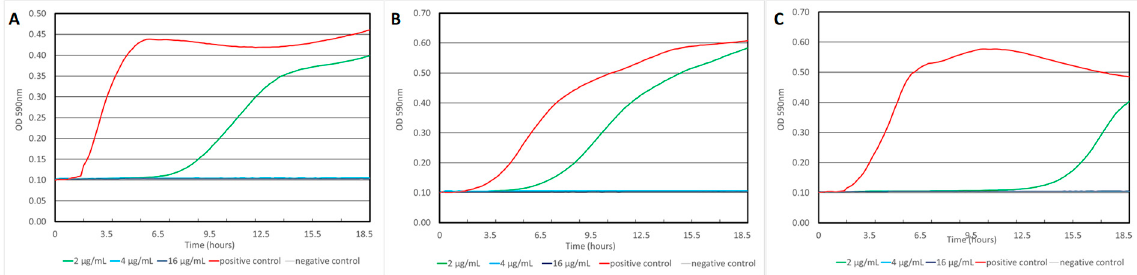
Figure 6. Bacterial growth inhibition exhibited by 15d against ( A ) S. aureus ATCC 25923, ( B ) MRSA (CF-Marseille); ( C ) Bacillus cereus ATCC 11778 with different concentrations. Positive control was bacteria only and negative control was media only.